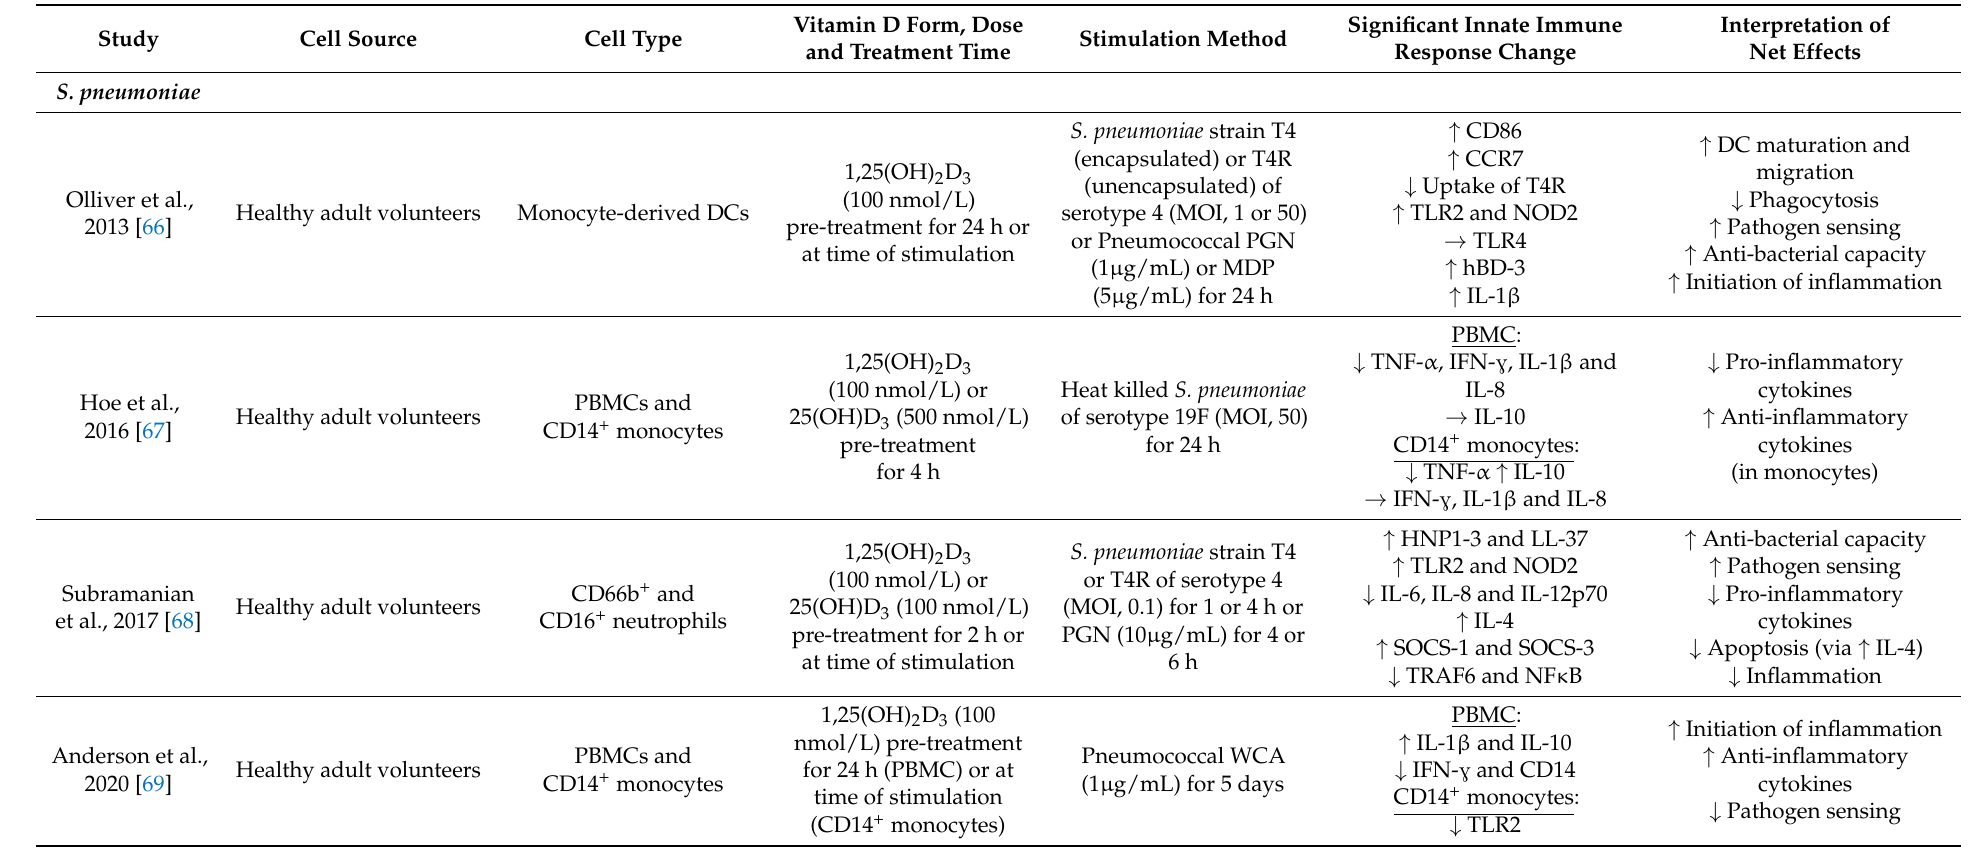
Table 1. Characteristics of studies describing the immunomodulatory effects of vitamin D on innate immune cells following challenge with Streptococcus pneumoniae , respiratory syncytial virus and influenza